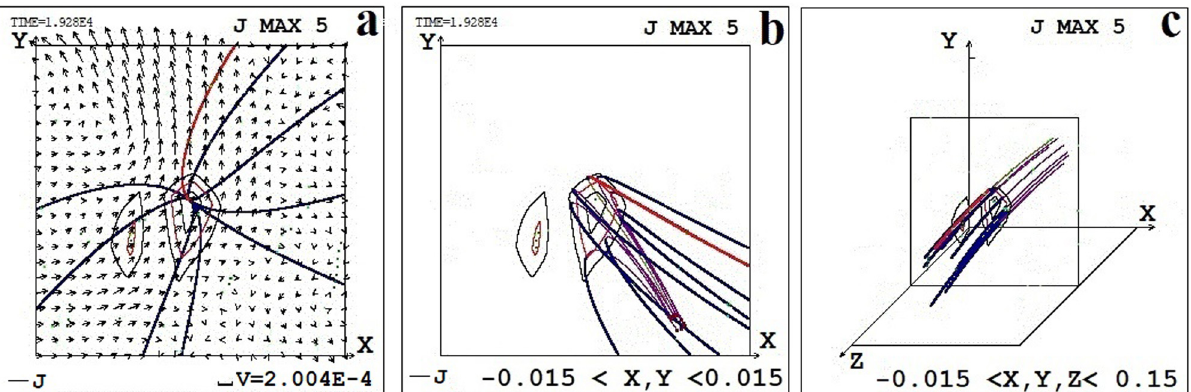
Figure 8: The con fi guration of the magnetic fi eld and the plasma fl ow in a region with a linear size of 0.03 ( 12 mm ) in the center of which the 5th maximum of the current density is located. The Z axis is directed along the magnetic fi eld vector taken at the point of maximum current density. The plane ( X Y , ) perpendicular to the magnetic fi eld vector is the plane of the con fi guration in which the current sheet is best expressed. ( a ) The magnetic fi eld in the plane of the con fi guration, represented by lines tangent to the projections of the vectors of the magnetic fi eld on the plane and the vector fi eld of velocities, the scale of the velocity vector is shown. ( b ) Projections of magnetic lines onto the plane of the con fi guration. ( c ) Three - dimensional con fi guration of the magnetic fi eld near the point of maximum current density.